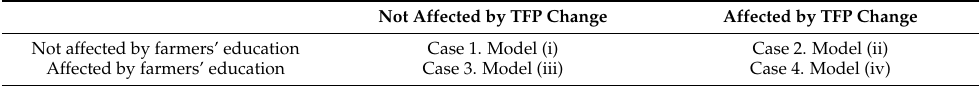
Table 1. Models under different circumstances affecting rural–urban income gap. Not Affected by TFP Change Affected by TFP Change Not affected by farmers’ education Case 1. Model